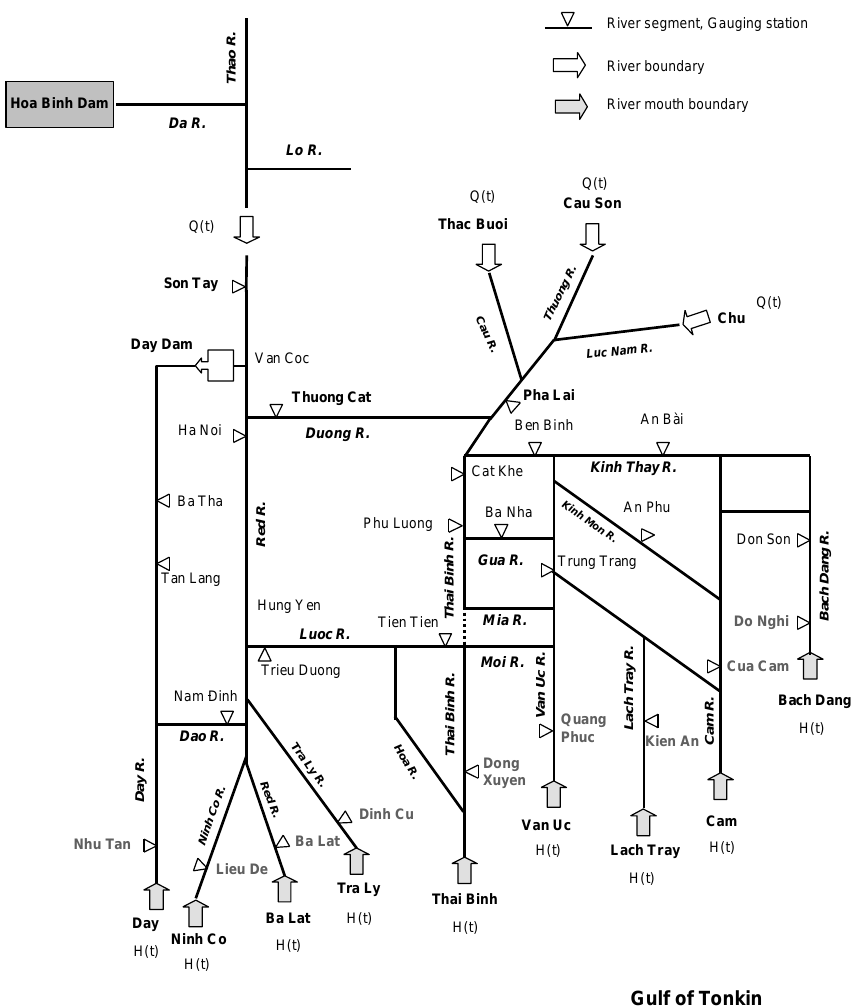
Figure 2. Diagram of the network considered in the Red River delta for the MIKE11